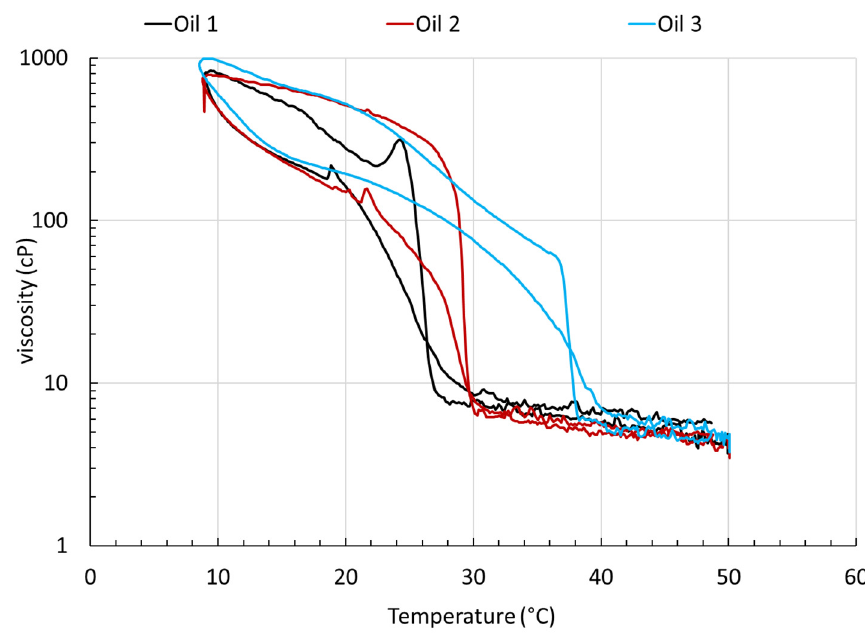
Figure 3. Viscosity as a function of the cooling/heating cycle 50 °C → 8 °C → 50 °C for oils 1, 2, and 3, measured by applying a constant shear of 25 s − 1 and a cooling/heating rate of 1 °C/min. Table 4. WATs, maximum viscosity reached and percent viscosity reduction of oils relative to their untreated counterpart oils 1, 2 and 3. Negative values indicate viscosity increase.